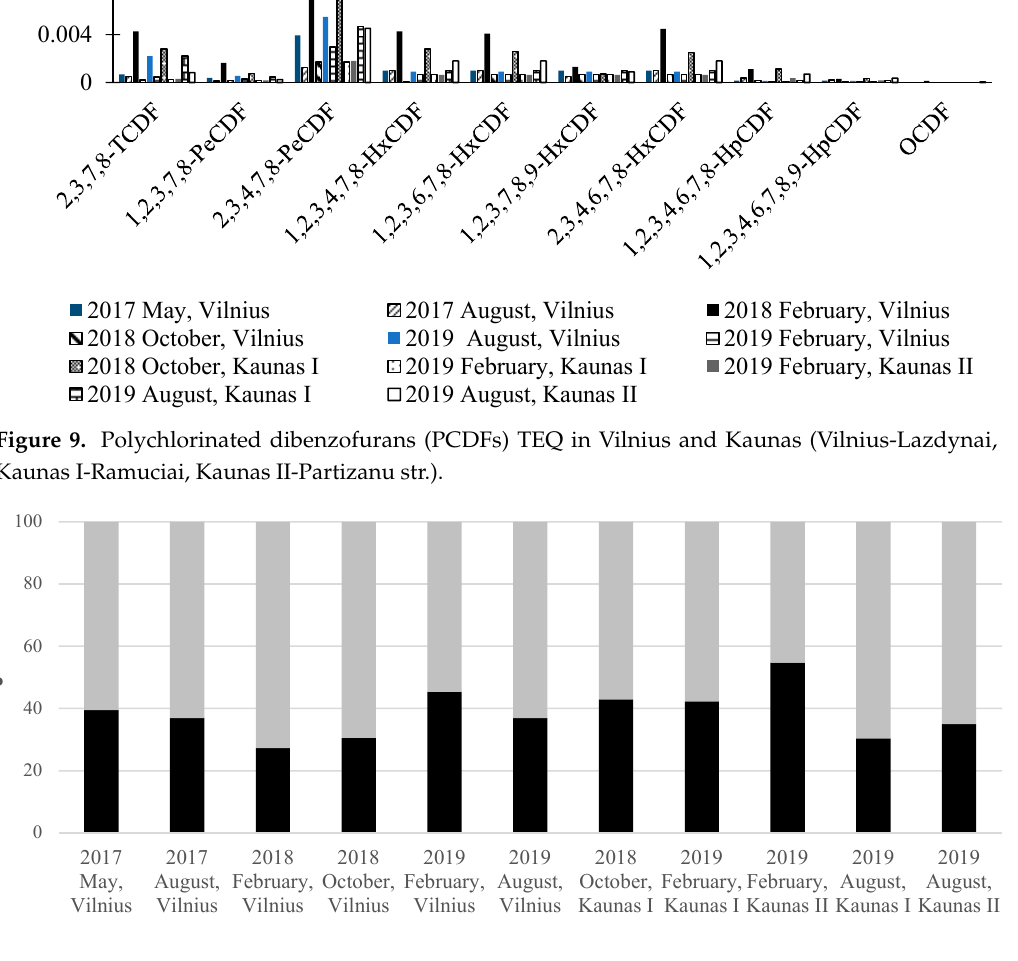
Figure 10. Percentage of total PCDD/F concentration in Vilnius and Kaunas (Vilnius-Lazdynai, Kaunas I-Ramuciai, Kaunas II-Partizanu str.).